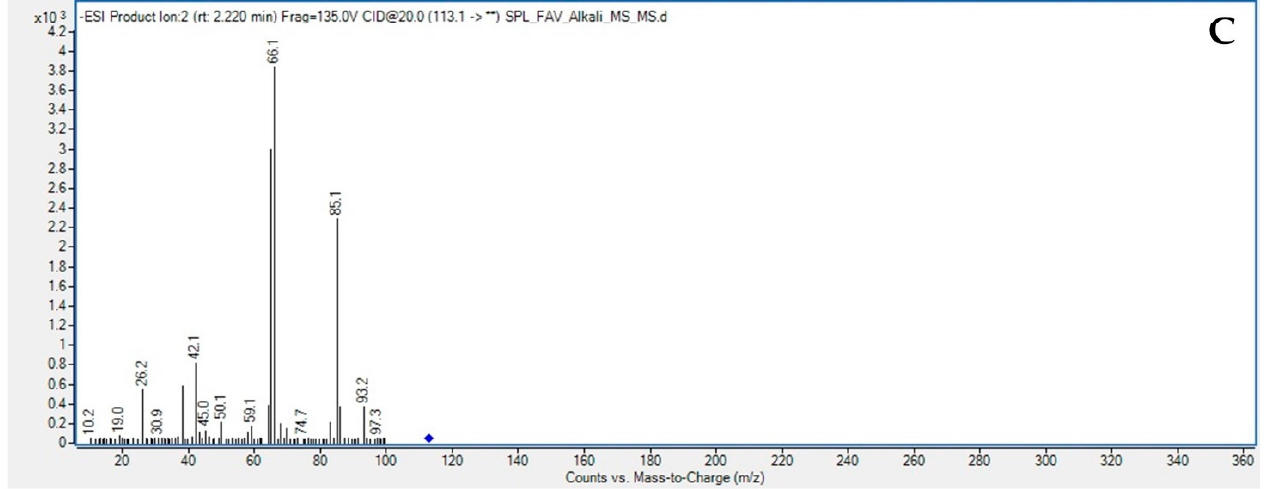
Figure 5. Base peak chromatogram ( A ); precursor ion scan ( B ); product ion scan ( C ) of alkali degradation sample using LC-MS/MS.